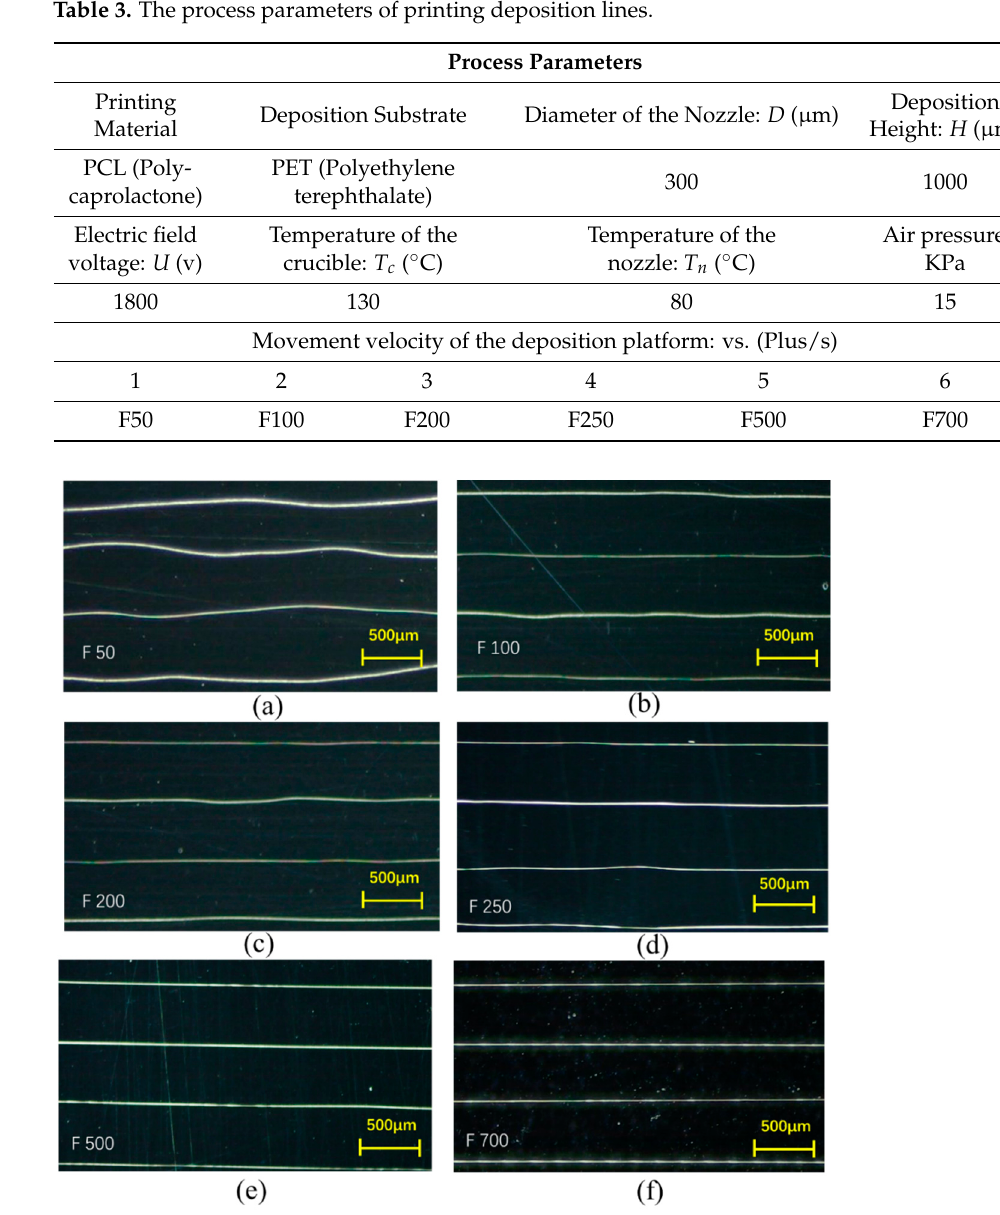
Figure 12. Variation of straightness of the deposition line under different velocities. ( a ) F50; ( b